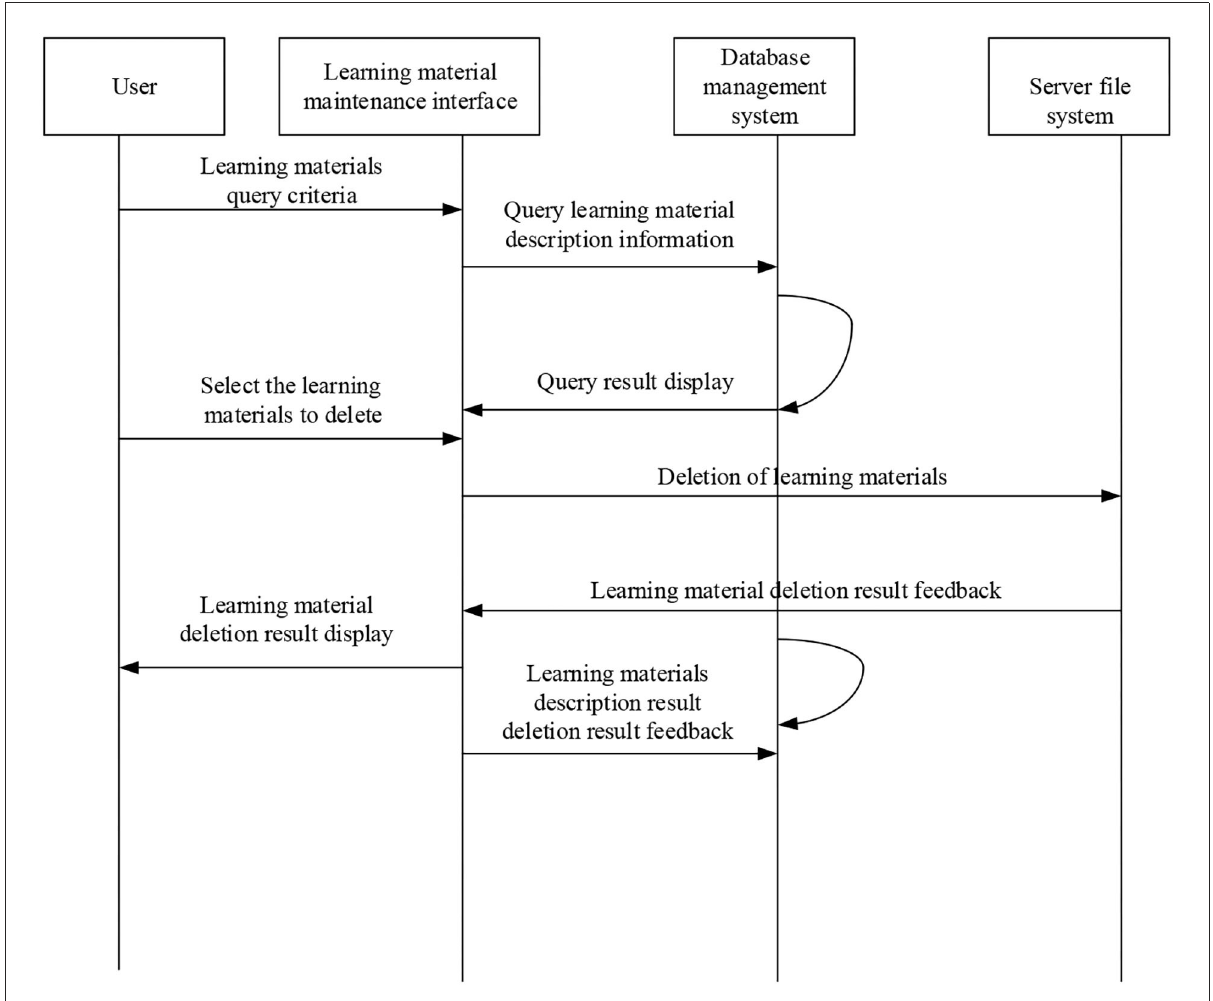
FIGURE11 Sequence diagram of micro-video